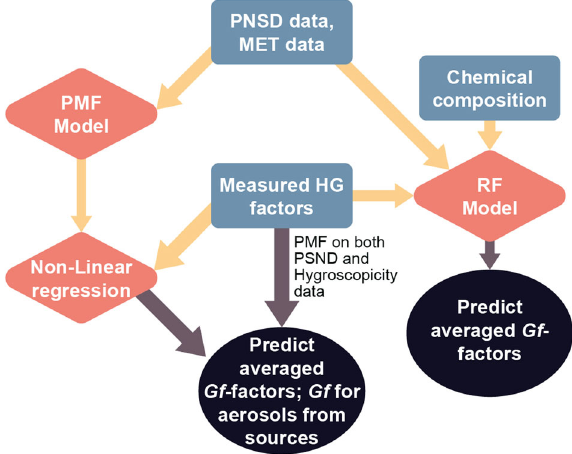
Fig. 2 Schematic of model development scheme. This shows the relationship of different components of the